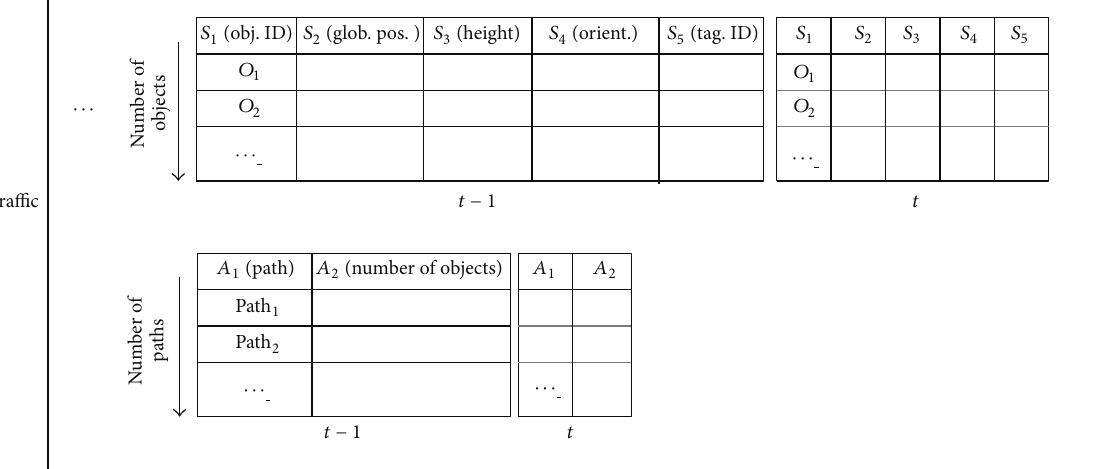
Figure 3: The scenario generator generates an application-specific data and the data is processed by the execution model. E Data